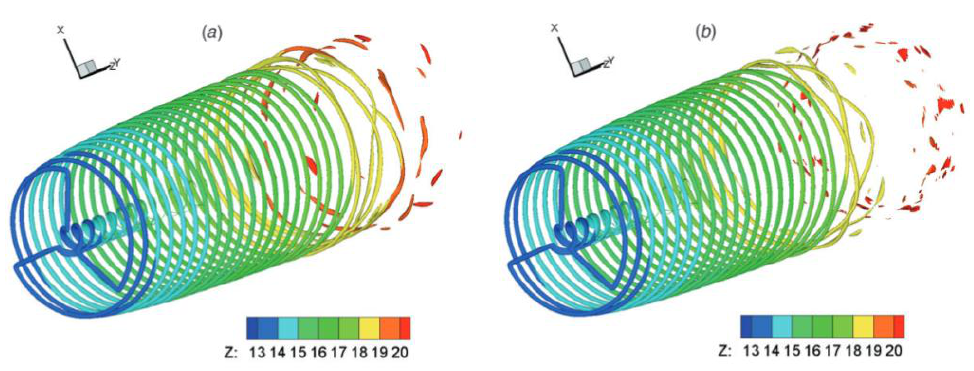
Figure 11. Tip vortex instability due to harmonic perturbation of blade forces of different frequencies: ( a ) f D / U ∞ = 4 and ( b ) f D / U ∞ = 10. Reprinted with permission from Ivanell et al. [110]. 2010, John Wiley and